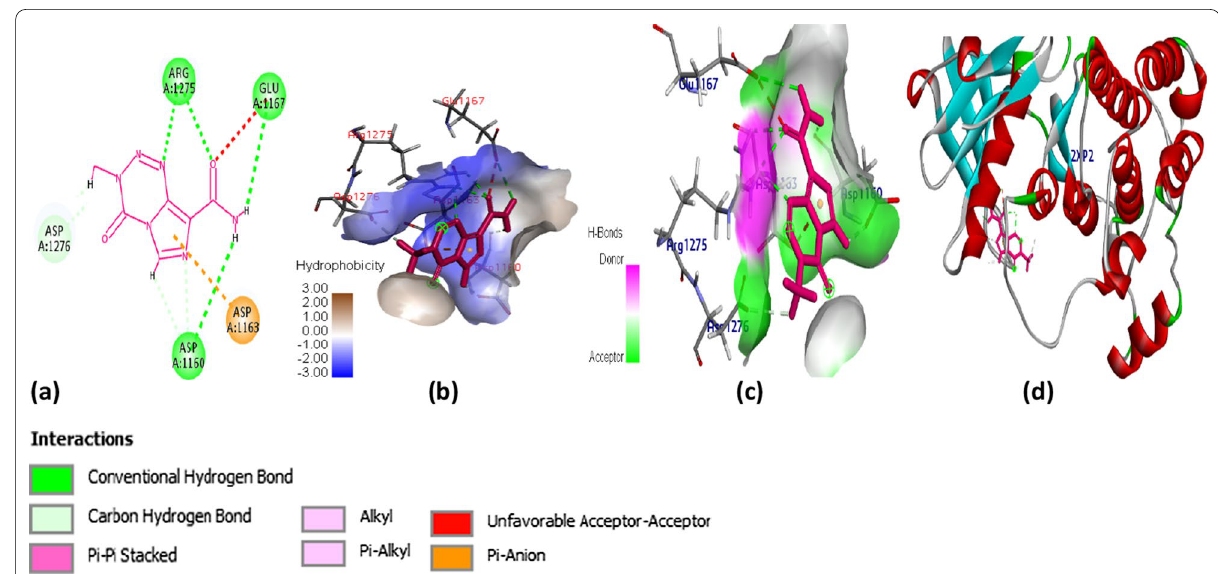
Fig. 11 2D and 3D interaction images of drug Temozolomide at the binding sites of protein ALK (2XP2: RC (S1,